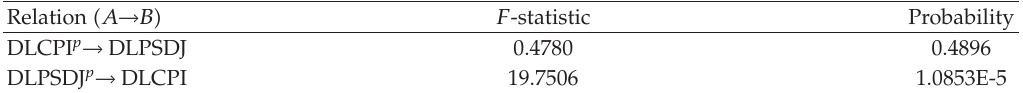
Table 5: Test for nonlinear causality (cid:5) asymmetric case for positive returns (cid:6) . If P > . 05, then at 5% we accept the null hypothesis that A does not cause B . The M-G model parameters were τ 1 (cid:8) τ 2 (cid:8) 1, and c 1 (cid:8) c 2 (cid:8) 2. Relation (cid:5) A → B (cid:6)